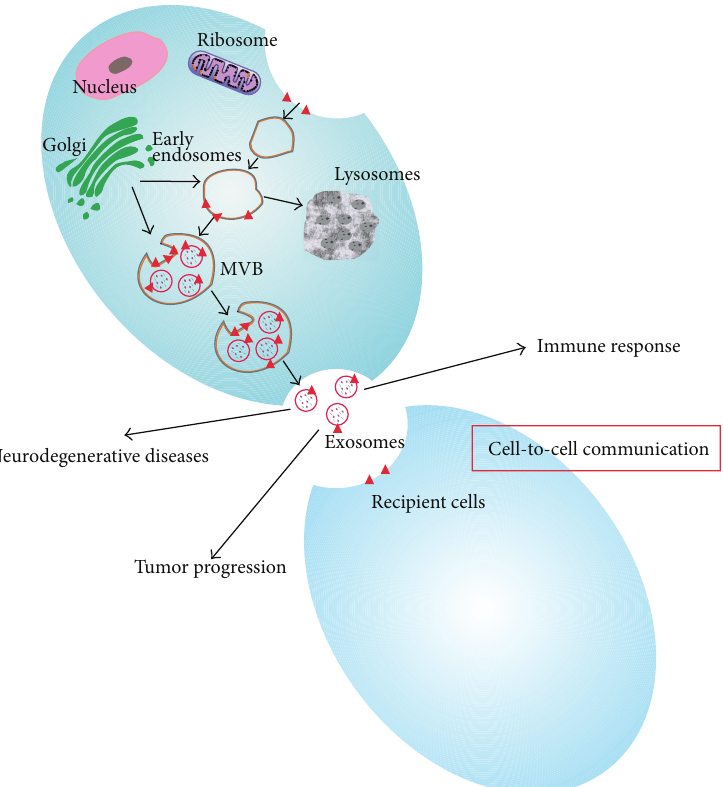
Figure 1: Biogenesis and action of exosomes. Exosomes are formed by inward budding of membrane of the multivesicular bodies (MVBs); when MVBs fused with the membranes, the exosomes are released. Exosomes can deliver lipids, proteins, and nucleic acid to recipient cells when circulating in the extracellular space. Exosomes are important mediators of intercellular communication and play significant roles in immune response, tumor progression, and neurodegenerative disease among